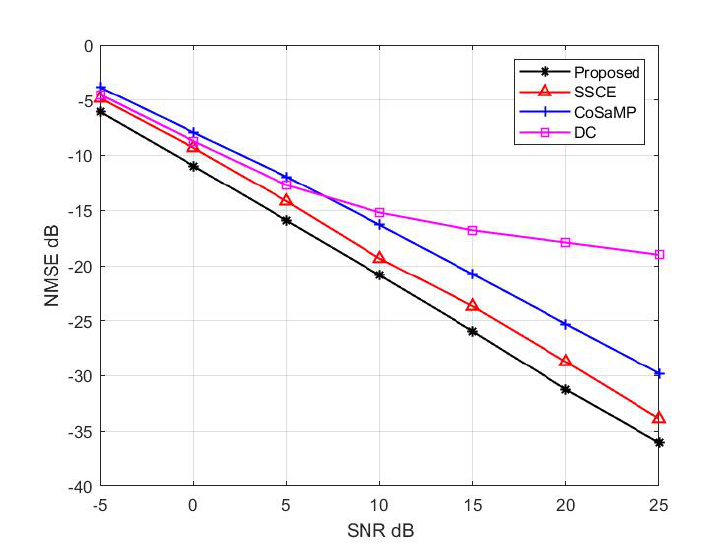
Figure 8. Comparison of normalized mean square error under different algorithms.